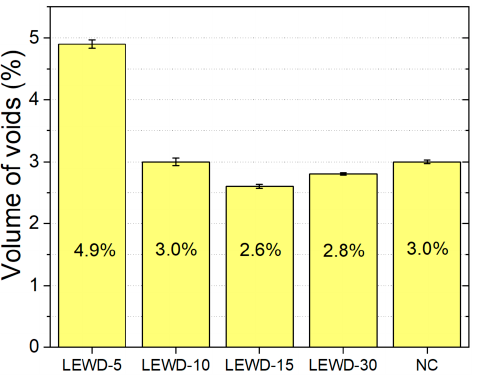
Figure 7. Effect of the LEWD parameter on the volume of voids of the 350 mm-long walls.